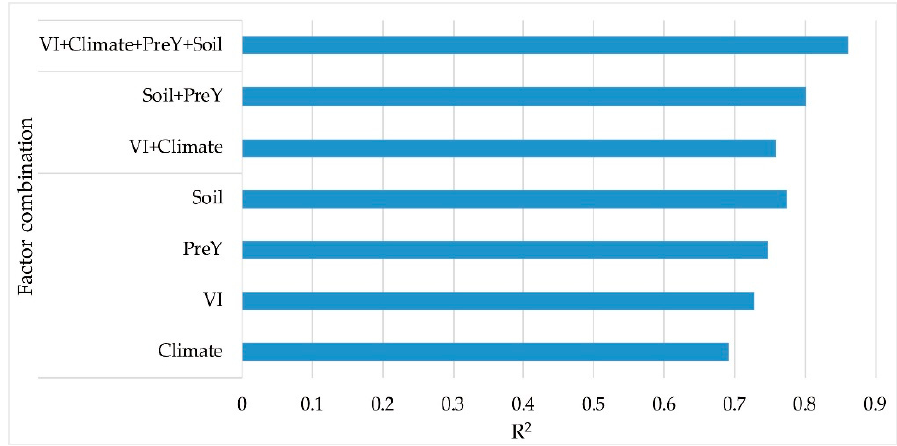
Figure 6. The performance of the AdaBoost model using different combinations of the multi-source